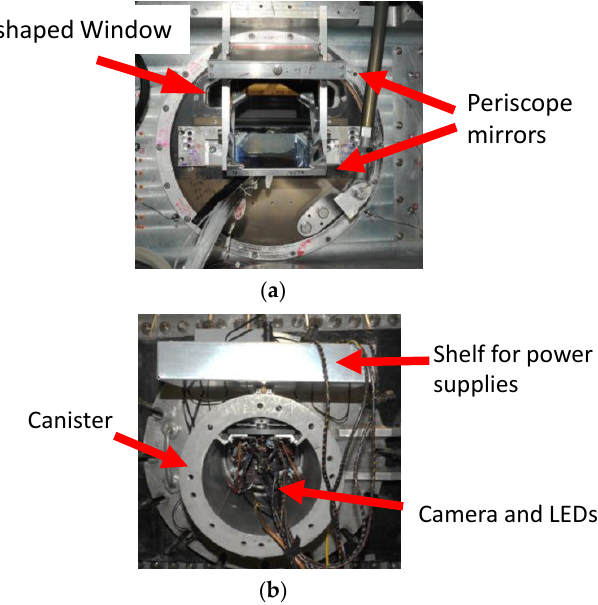
Figure 3. Mounting of equipment at 0.3-m TCT: ( a ) optical setup showing the “D-shaped” window and the periscope assembly; and ( b ) canister mounted onto the side of the tunnel containing the camera and LED illumination sources.